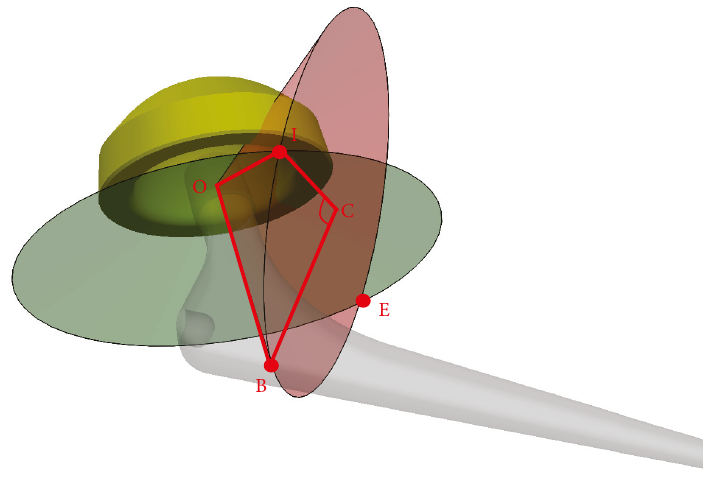
Figure 9: Cup cone and stem cone overlap. ∠ BCI is the maximum internal rotation angle at the defined flexion angle.